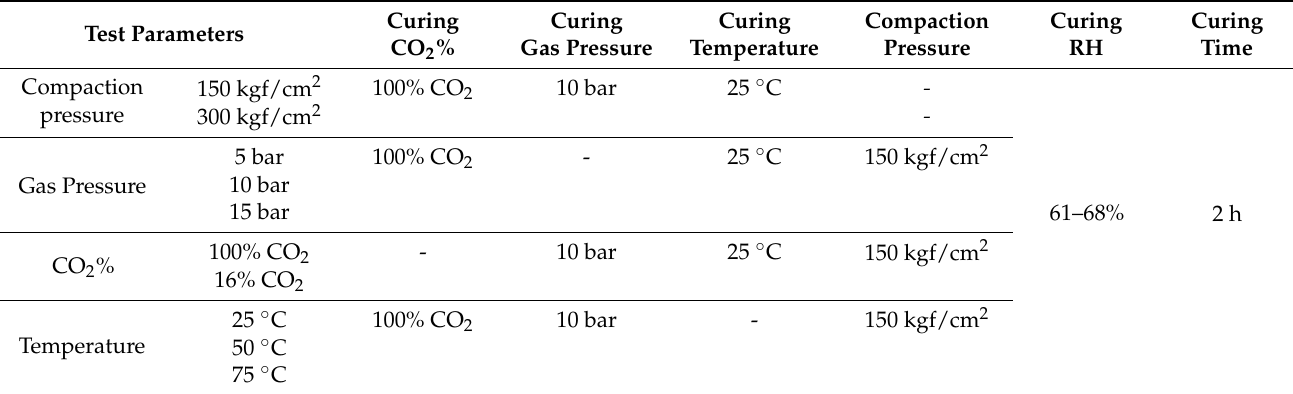
Table 3. Experimental parameters to produce carbonated